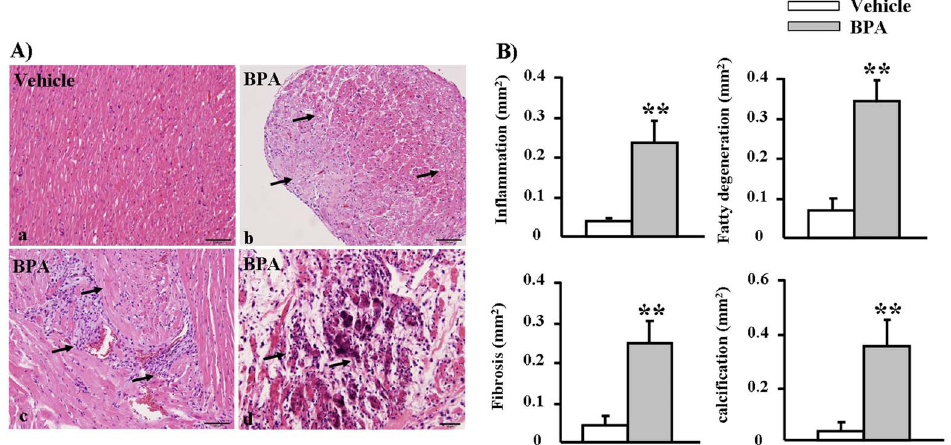
Figure 9. Pathological analyses of WHHL rabbit hearts at 12 weeks. (A) Heart specimens stained with H&E show disarrayed myocardiocytes along with (b) fatty degeneration (c) inflammatory cell infiltration, fibrosis, and (d) calcification in the BPA-exposure group. (B) The lesion areas in the vehicle and BPA-exposure groups were quantified using an image analysis system. Data are expressed as the means 6 SD, n=6 for each group. ** p , 0.01 vs.